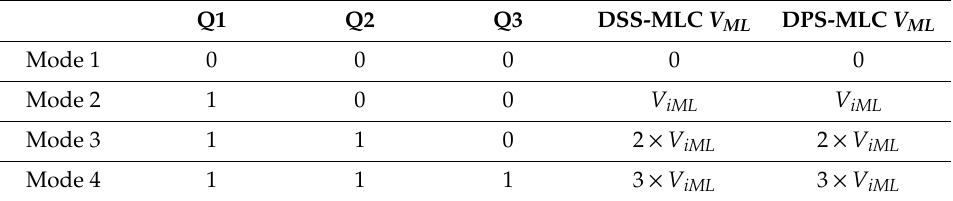
Table 1. Output voltages according to the switching state in each mode.